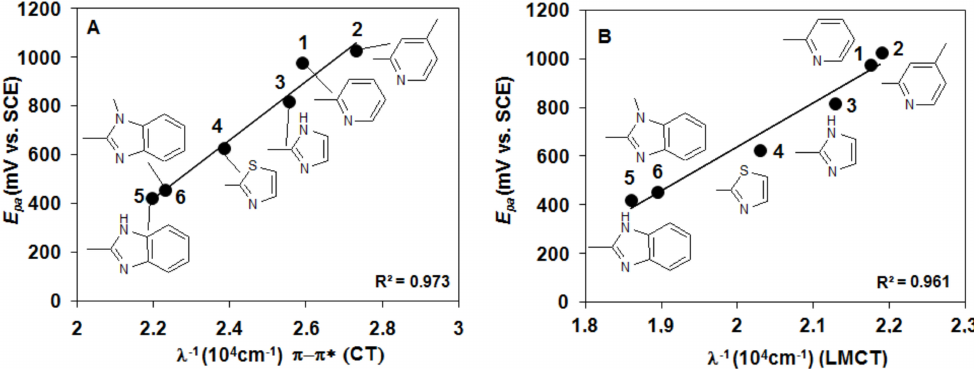
Figure 3. Correlation between the oxidation potential of the [Mn II (HL 1–6 )Cl 2 ] complexes and the energy of the π – π * absorption band ( A ). Correlation of the oxidation potential of the [Mn II (HL 1–6 )Cl 2 ] complexes and the energy of the LMCT absorption band ( B ) in